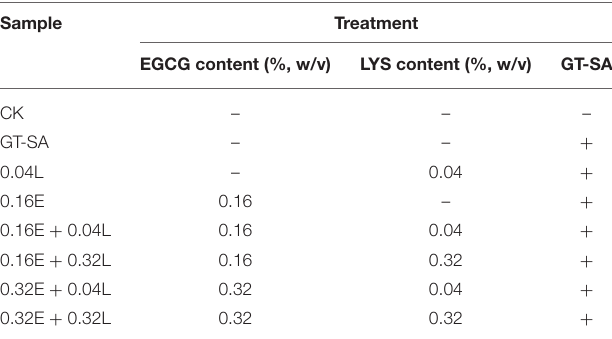
TABLE 1 | Sample preparation with different epigallocatechin gallate (EGCG) and/or lysozyme (LYS) contents. Sample